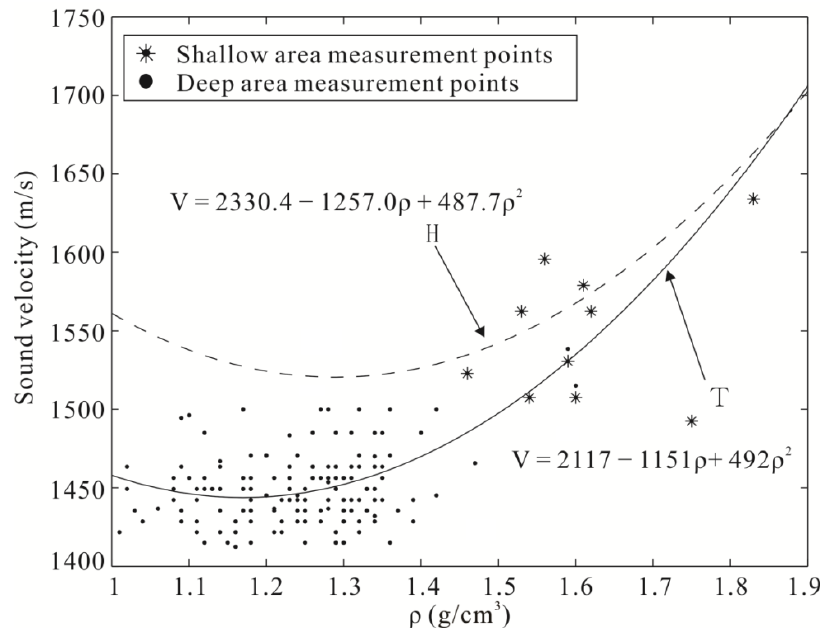
Figure 5. Wet bulk densities versus sound